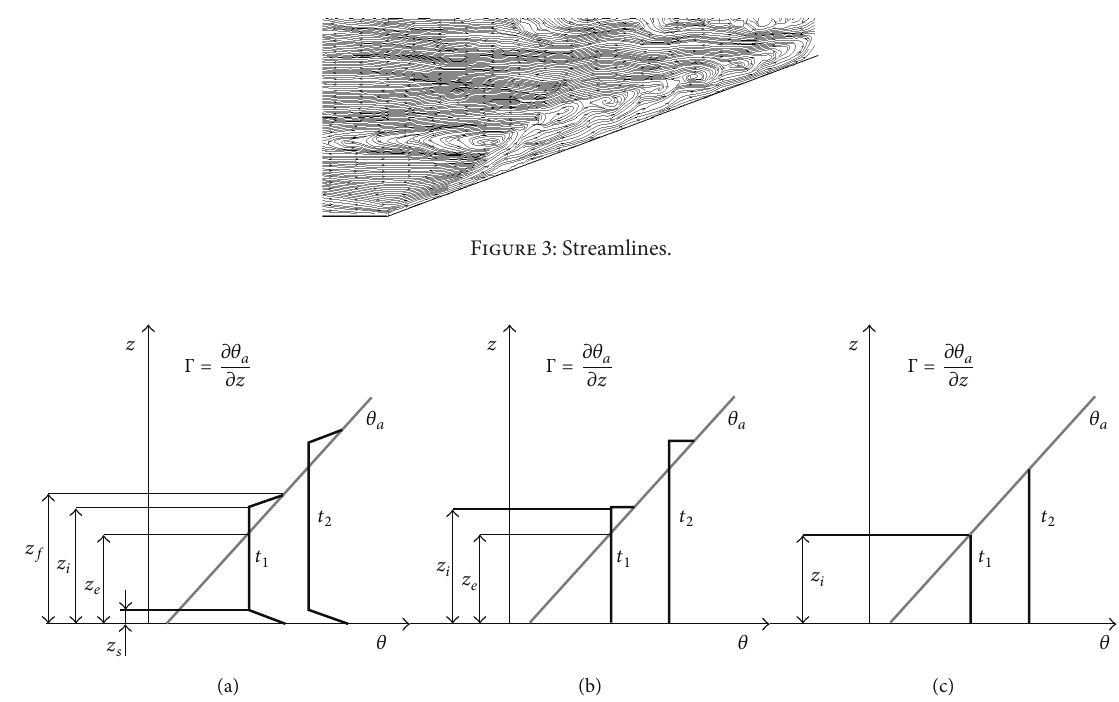
Figure4:Schematicrepresentationofthetemperatureevolutionwithintheatmosphericboundarylayeratdifferenttimeinstants; 𝜃 𝑎 indicates the background temperature; in (a) the superficial and entrainment layers are shown while they are not considered in (b).